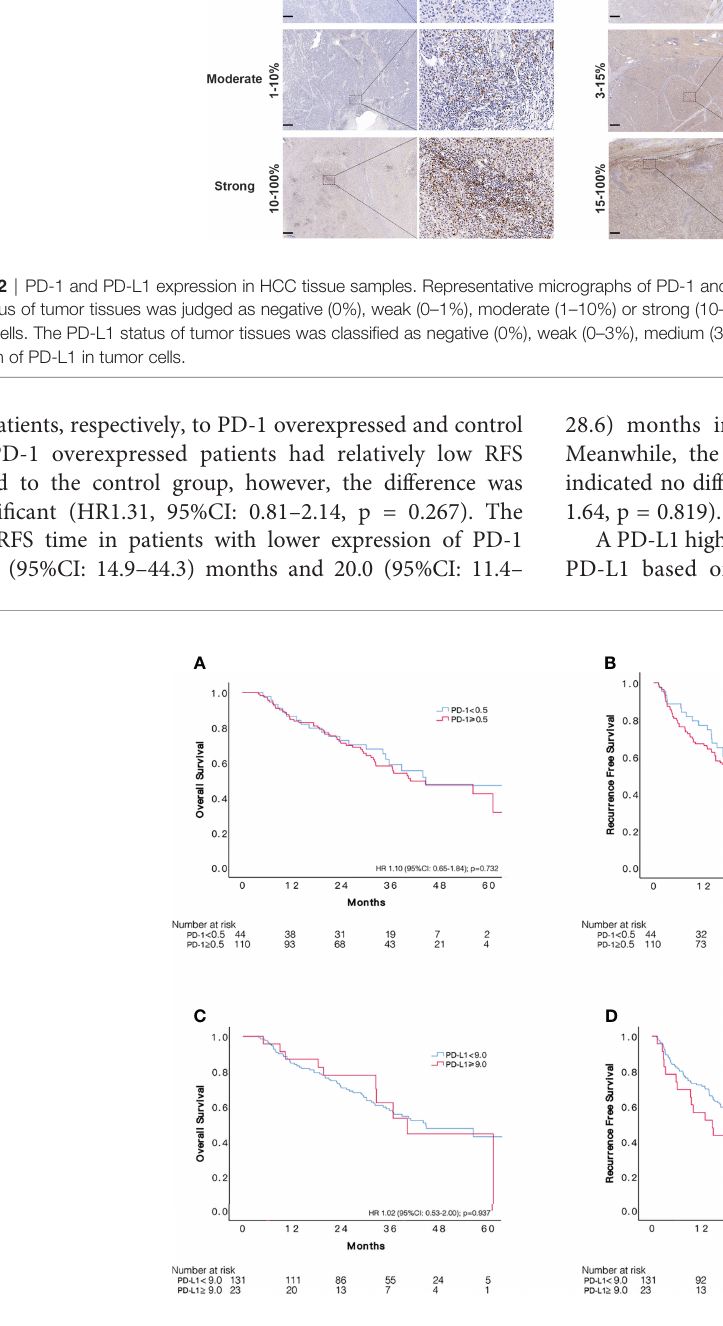
FIGURE 3 | Comparisons of survival among patients with different status of PD-1 and PD-L1 expression in 154 unselected HCC patients who received adjuvant sorafenib. Kaplan – Meier curves of OS and RFS according to expression of PD-1 (A, B) and PD-L1 (C, D) .